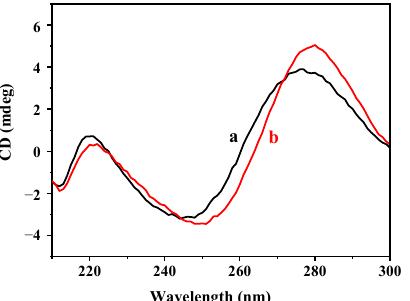
Figure 14. The circular dichroism spectra of ( a ) DNA2-Ag NCs and ( b ) DNA2-Ag NCs/Cu 2+ .